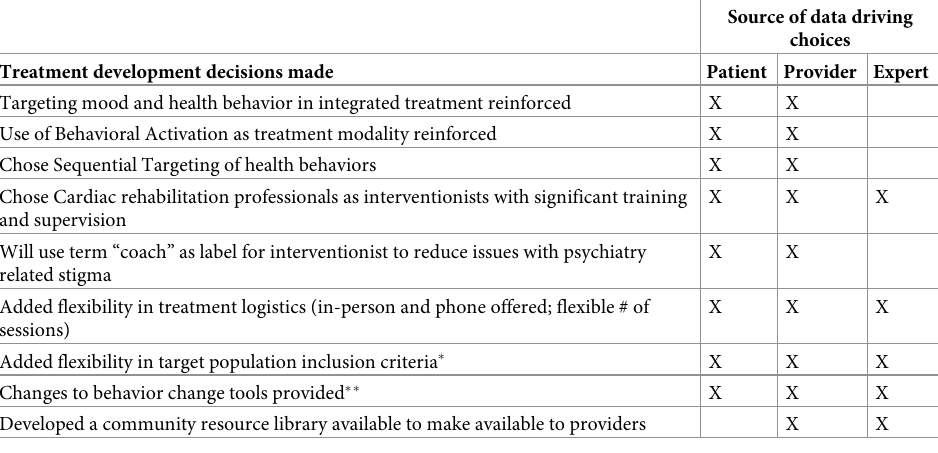
Table 2. Treatment development decisions made and the source of qualitative data that informed those